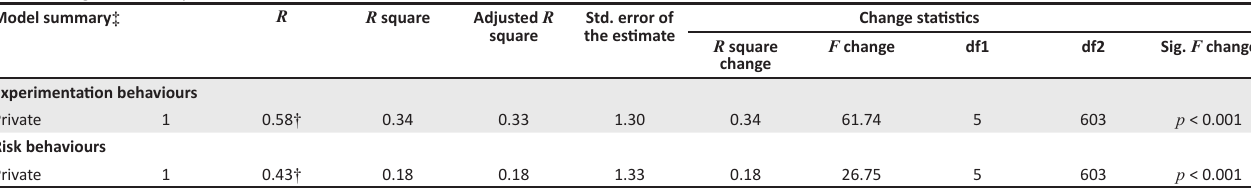
TABLE 4: Regression